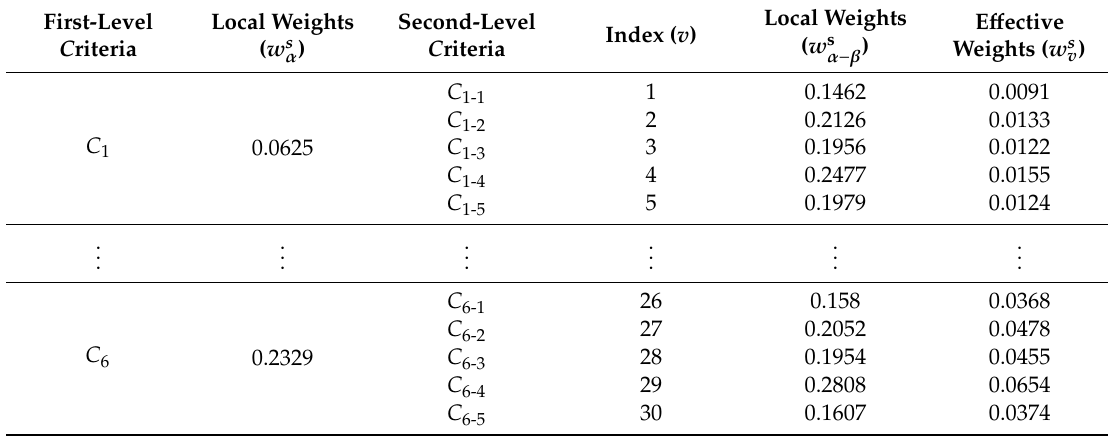
Table 5. Overall weights using the SWARA method.